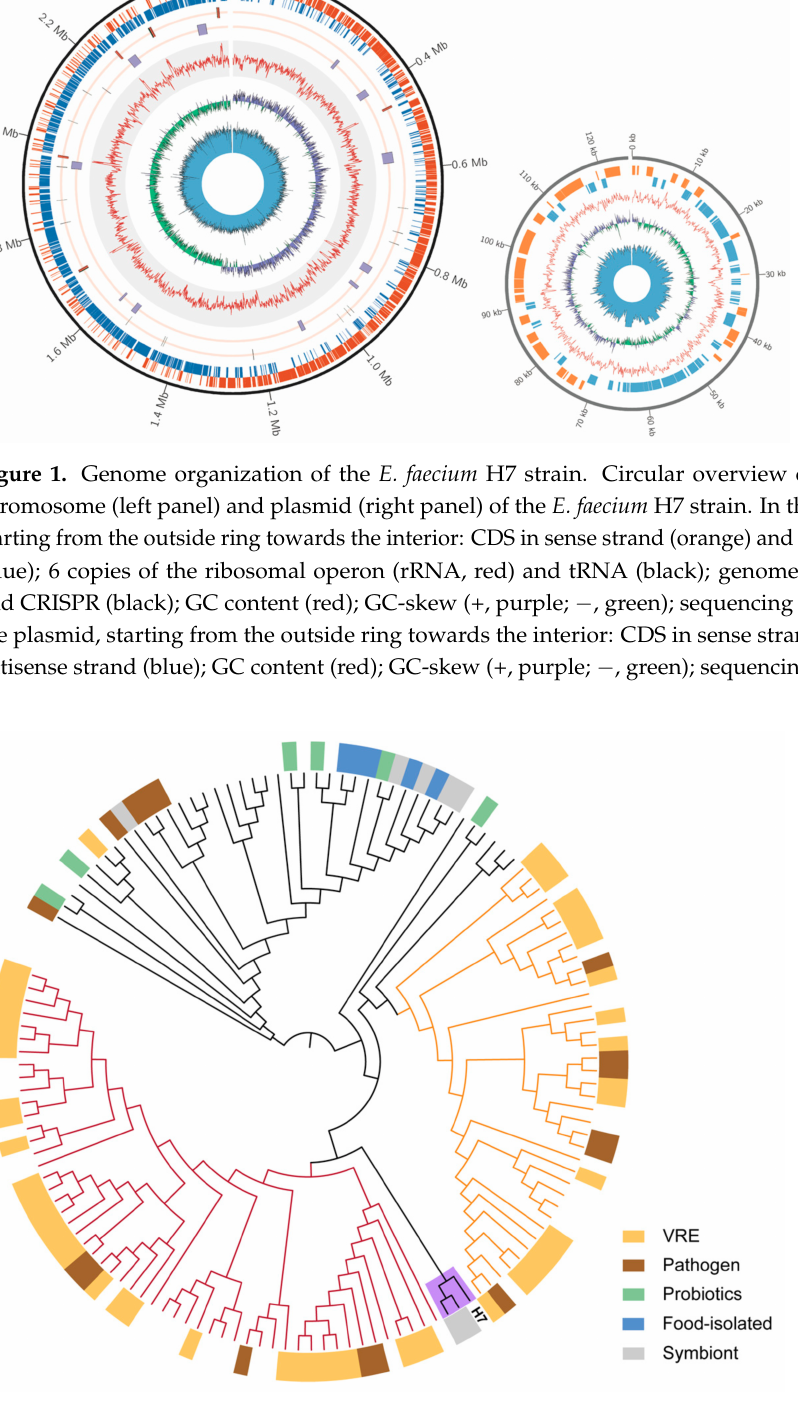
Figure 2. Maximum likelihood tree of E. faecium strains. The tree is based on core gene alignment of 136 E. faecium strains. H7 was closer to the human symbiont. The groups with dark red or orange branches mainly consist of vancomycin-resistant enterococci (VRE) and pathogenic